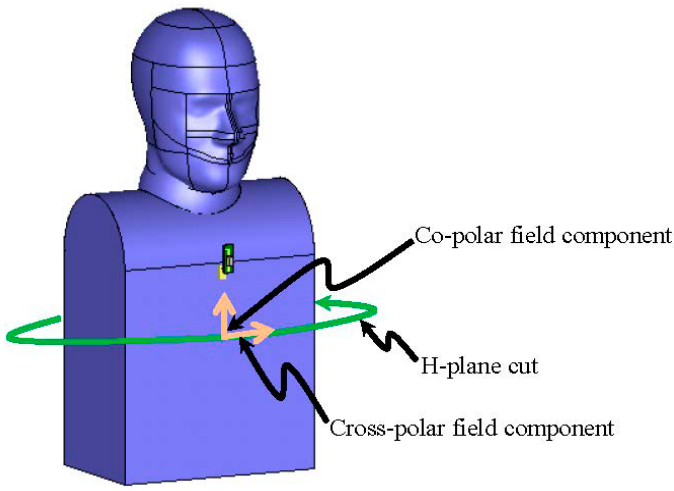
Figure 6. Numerical model of the DRA with head and torso anthropomorphic